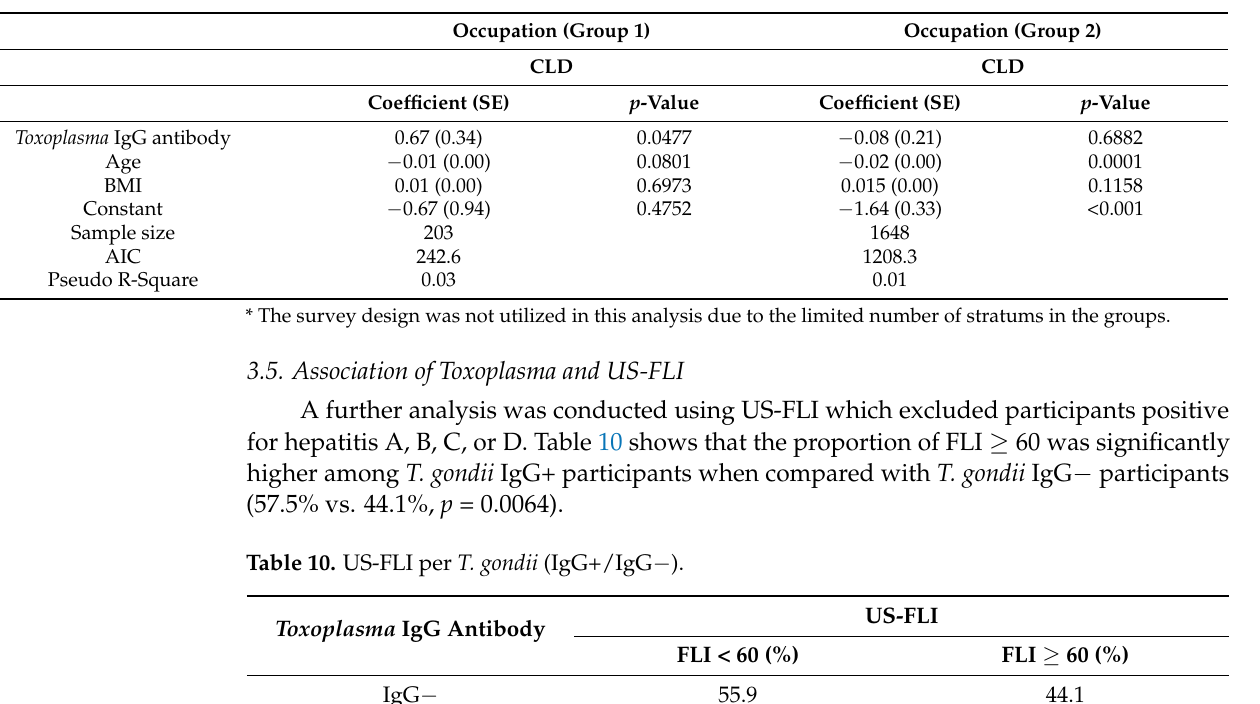
Table 9. Binomial logistic regression model for CLD on T. gondii IgG antibody—occupation (Group